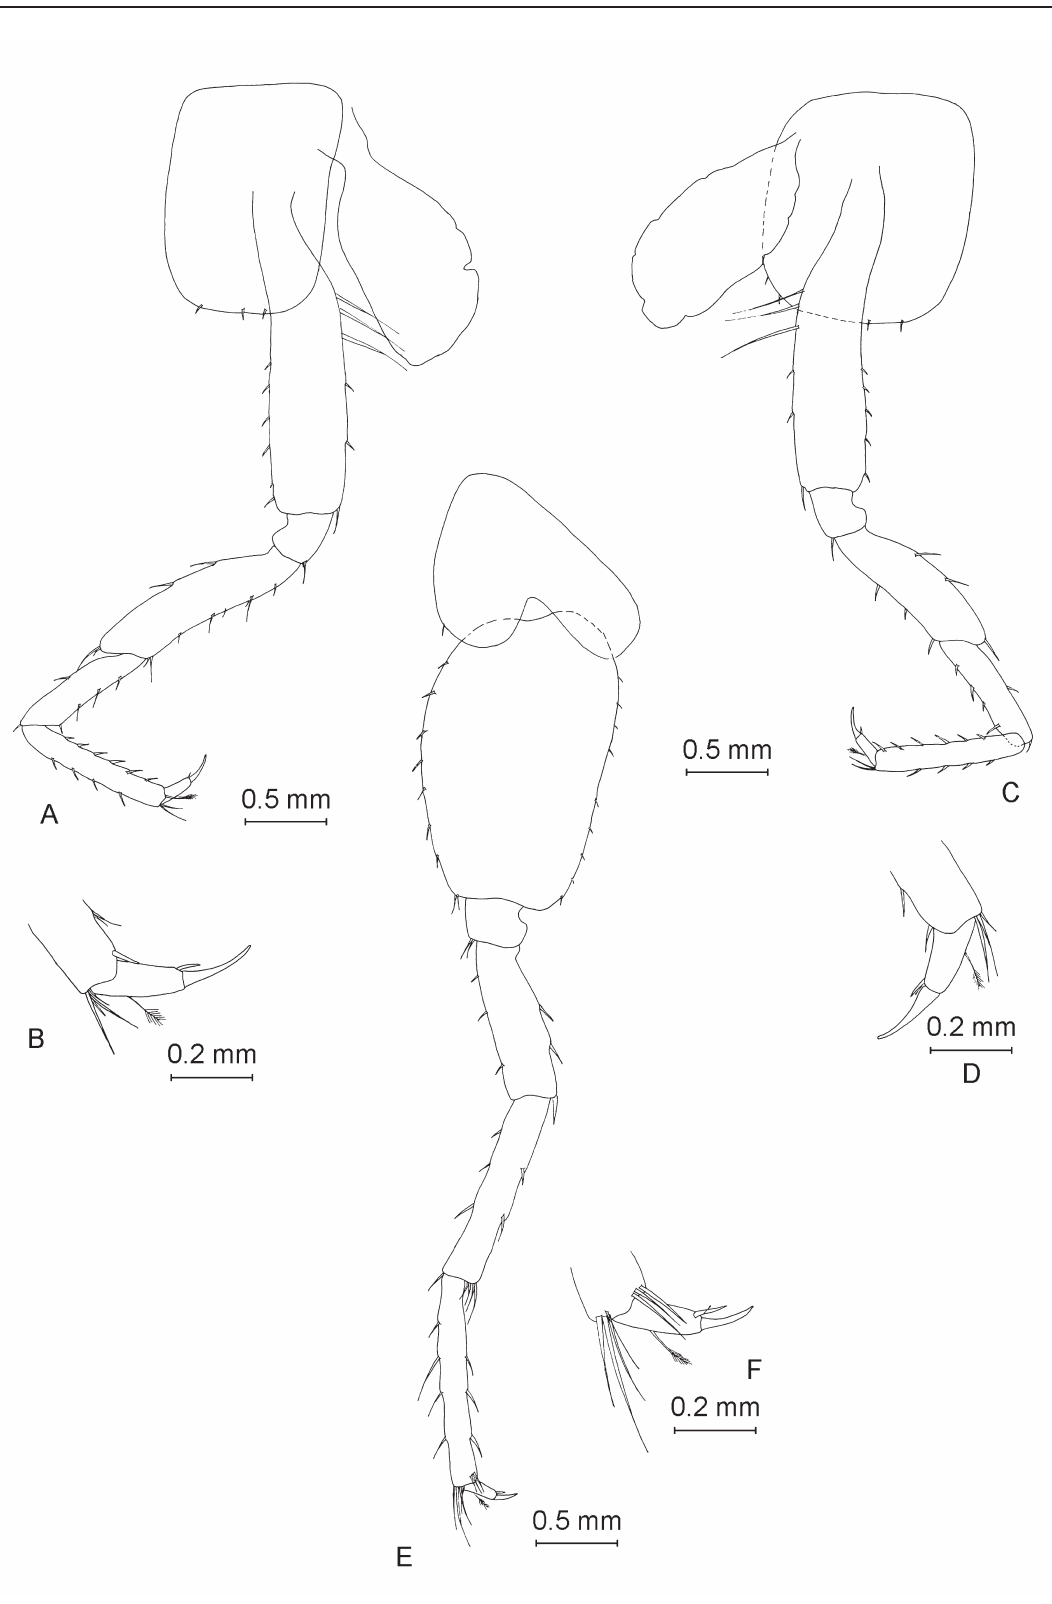
Fig. 6. ♂. A . Pereopod III. B . Dactylus of pereopod III. C . Pereopod IV. D . Dactylus of pereopod IV. E . Pereopod V. F . Dactylus of pereopod